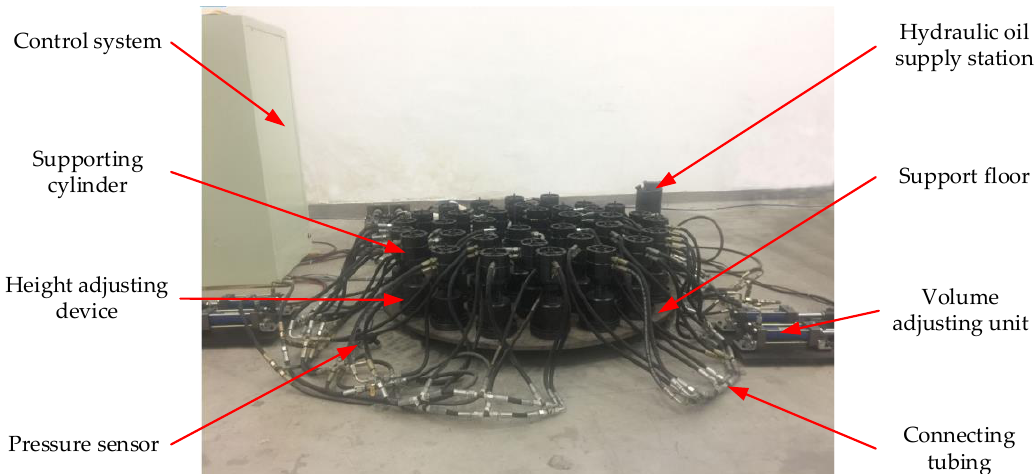
Figure 7. Flexible support system.